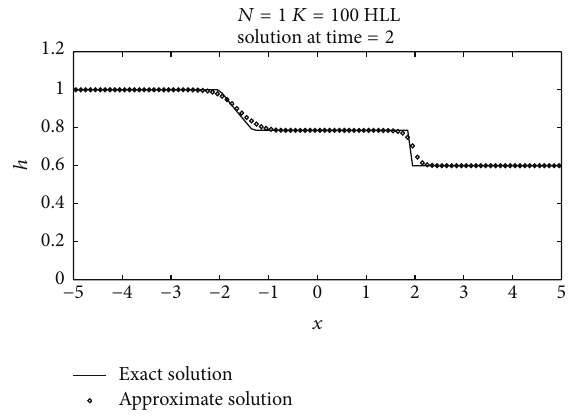
Figure 1: Exact solution and water depth profile obtained by the TVD-RK DG HLL method.